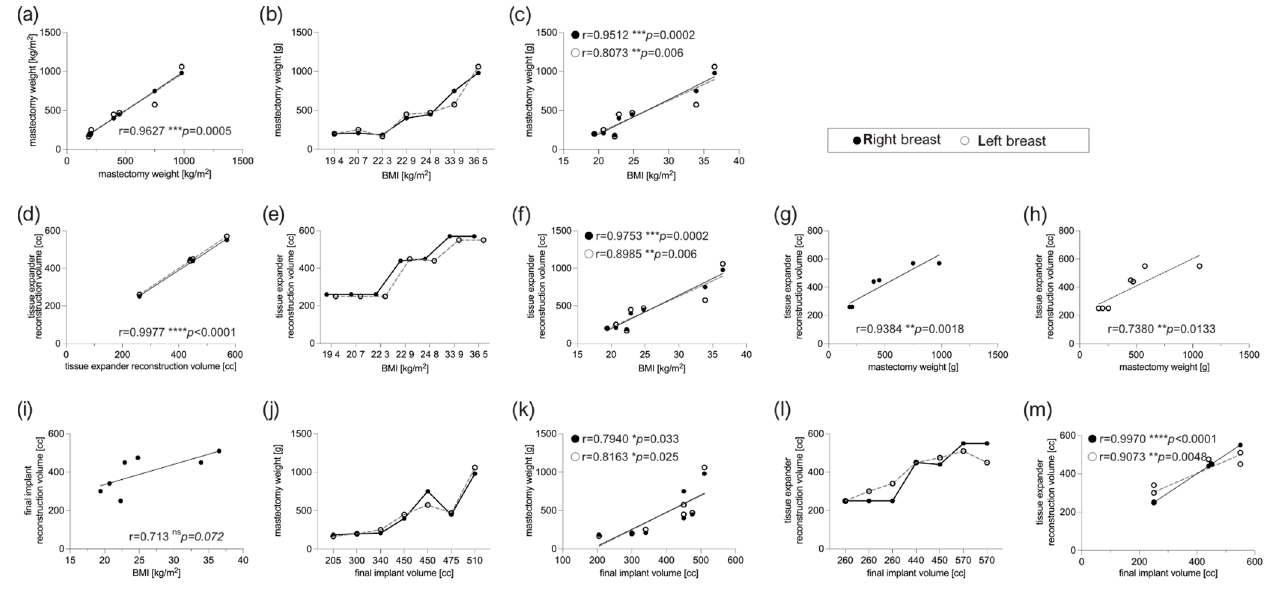
Figure 2. Intra-individual comparison of mastectomy weight, tissue expander reconstruction volume, and final implant volume. ( a ) Bilateral correlation of mastectomy weight obtained from left and right breast. ( b ) Mastectomy weight correlates ( c ) in a simple regression with BMI (R:w mast = 44.66×BMI-698.2, L:w mast = 41.38×BMI-613.4). ( d ) Bilateral correlation of tissue expander reconstruction volume obtained from left and right breast. ( e ) Tissue expander reconstruction volume correlates ( f ) in a